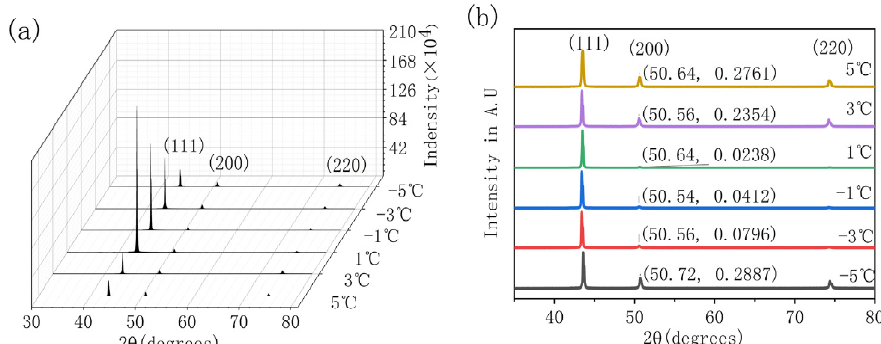
Figure 6. The XRD waterfall pattern ( a ) and y-axis offset stack pattern ( b ) of copper samples deposited at low temperatures from − 5 °C to 5 °C. The intensity ratio of (111) peak to (200) peak is shown in ( b ).